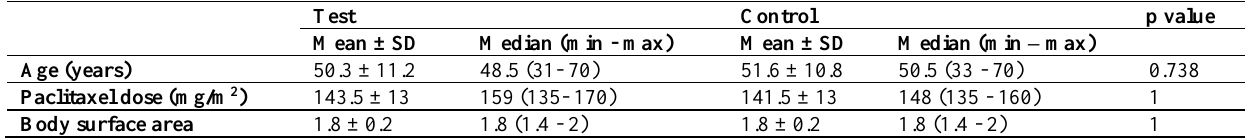
Table 1: Baseline patients’ characteristics